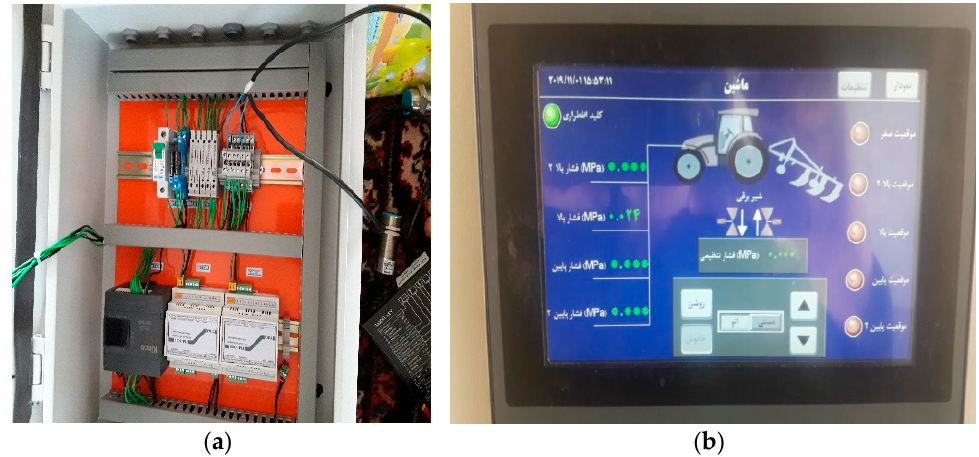
Figure 7. ( a ) Internal parts of the control panel and its related wiring, ( b ) HMI display and its active